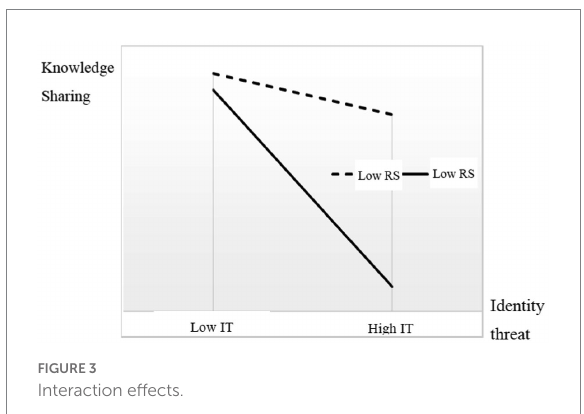
FIGURE 2 Structural model.